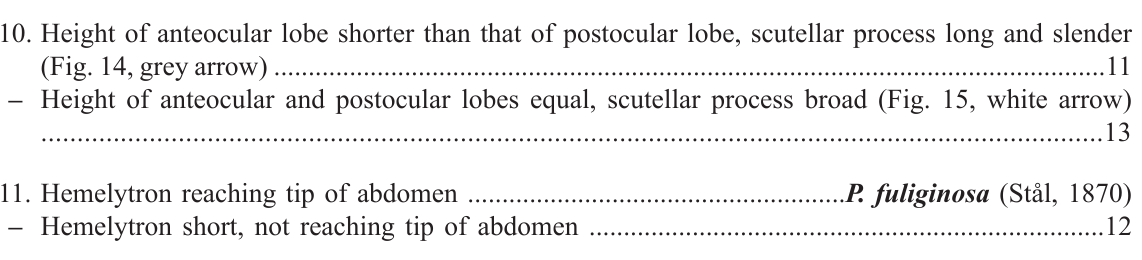
– Hemelytron short, not reaching tip of abdomen ...........................................................................12 12. Large (10.5 mm), scape reaching apex of clypeus, anterior pronotal lobe distinctly wider than posterior lobe (Fig. 14, green arrow) ............................................................ P. esakii Cao et al. , 2011 – Of medium size (8.10–9.03 mm), scape not reaching apex of clypeus, anterior pronotal lobe marginally wider than posterior lobe (Fig. 14, dark green arrow) ....................... P. minime sp. nov. 13. Large (10.52–10.96 mm), males with apodeme on mediosternite 8, transverse bridge of pygophore broad (Fig. 8, dark blue arrow), margin of anterior opening of pygophore rounded in lateral view, with sclerotized, angular ductifer ....................................... P. mysorensis sp.